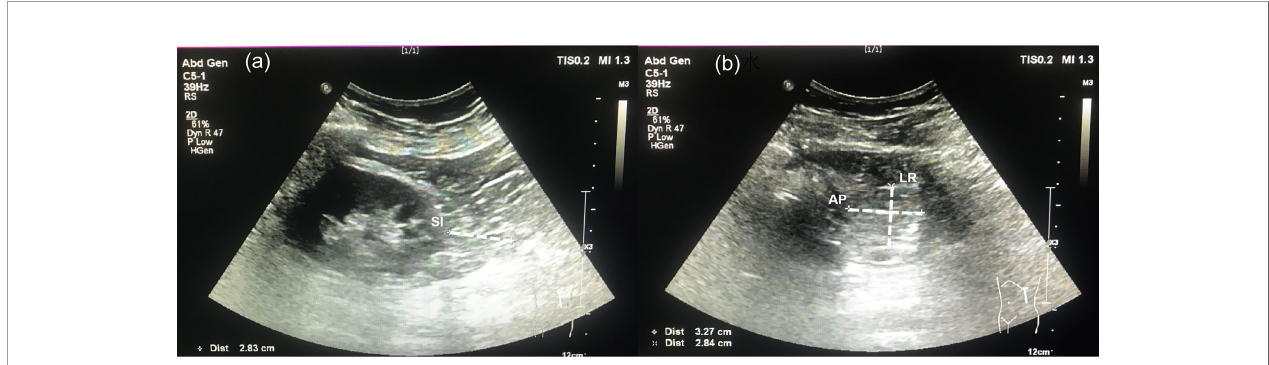
FIGURE 1 | Ultrasonographic measurement for perirenal fat volume. (A) A long-view of the inferior perirenal fat. Superior-inferior (SI) diameter was de fi ned as the maximal thickness between the fi brous membrane to the renal fascia. (B) A short-view of the inferior perirenal fat. The left-right (LR) diameter and anterior-posterior (AP) diameter were measured through the maximal short-axis view of the inferior perirenal